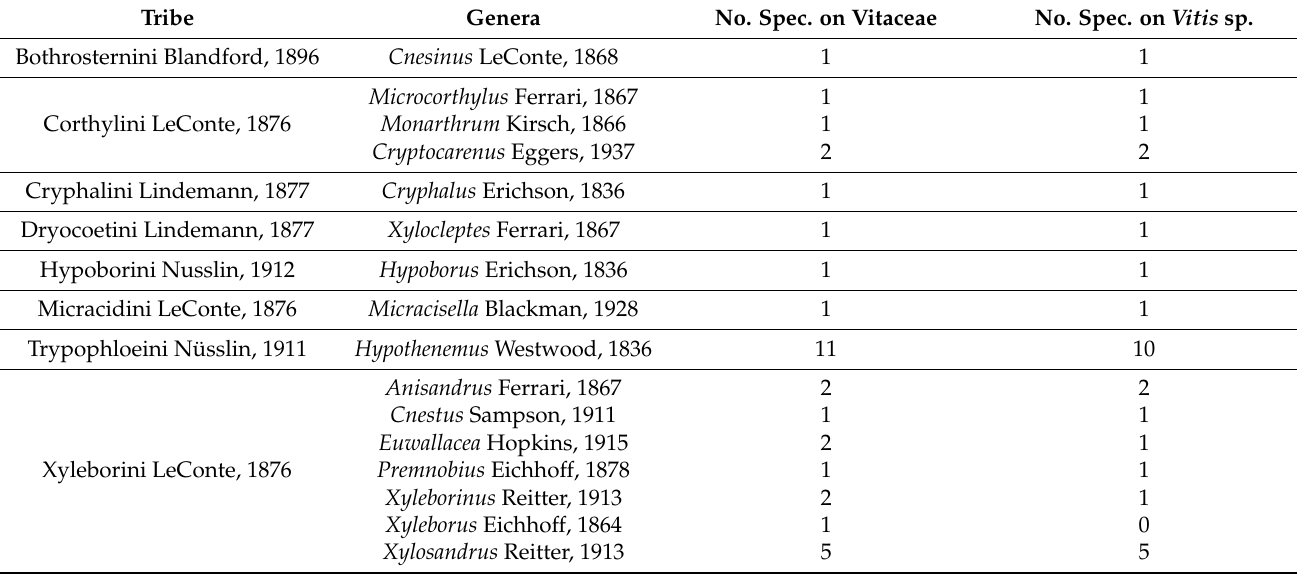
Table 1. Tribes and genera of Scolytinae developing on Vitaceae worldwide.